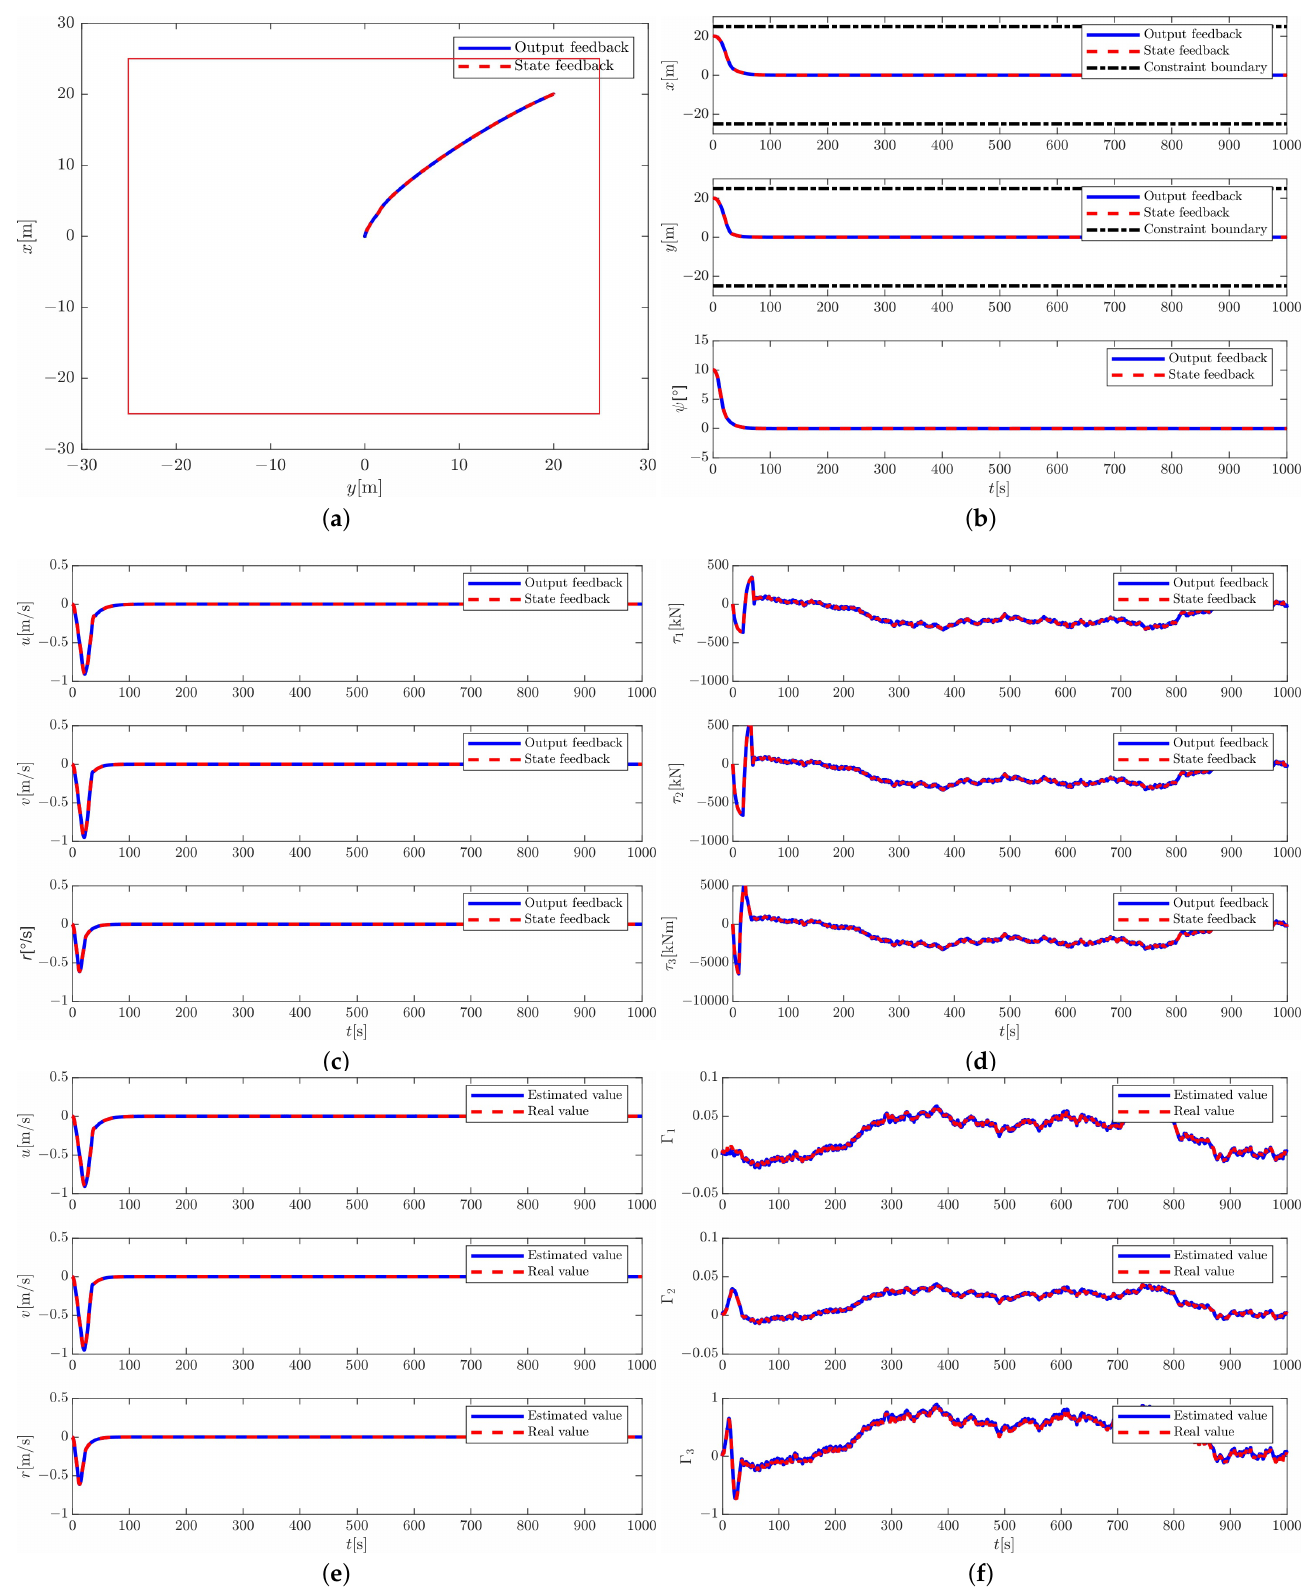
Figure 3. Comparison of simulation results for output feedback vs. state feedback: ( a ) ship horizontal motion trajectory; ( b ) ship position and heading; ( c ) ship speed; ( d ) actual thrust generated by ship thrusters; ( e ) estimated and true values of speed; ( f ) estimated and true values of set total